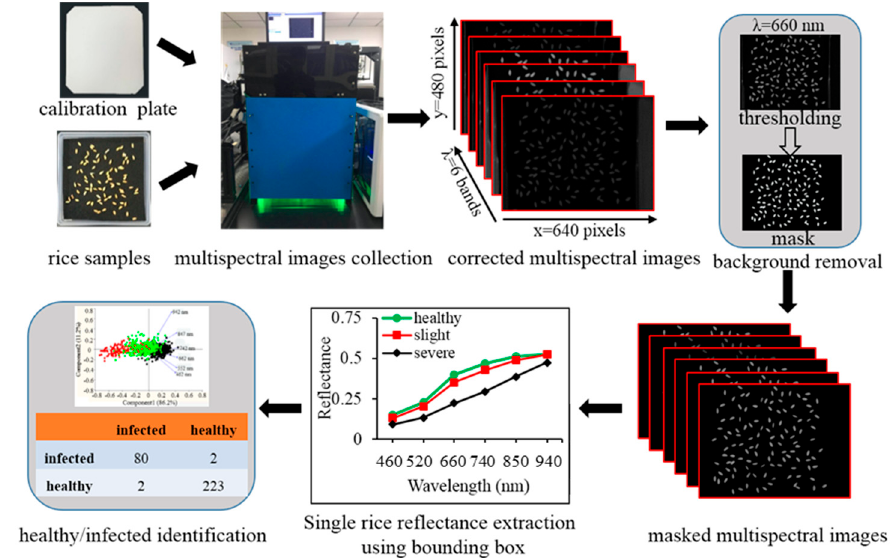
Figure 2. Schematic overview of the analytical procedure for rice false smut (RFS) disease detection.